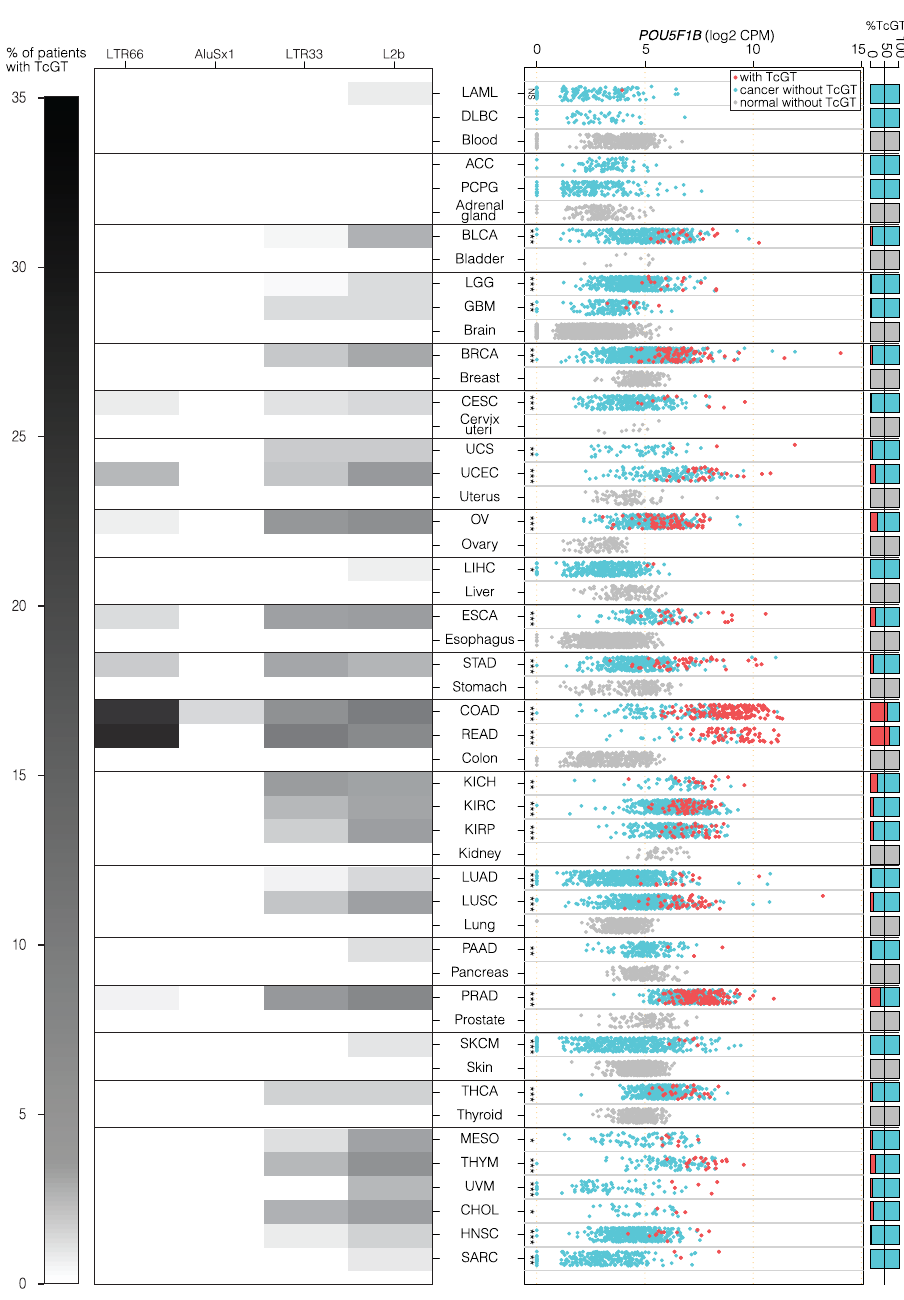
CESC cervical squamous cell carcinoma; CHOL cholangiocarcinoma; COAD colon adenocarcinoma; DLBC diffuse large B-cell lymphoma; ESCA esophageal carci- noma; GBM glioblastoma multiforme; HNSC head, and neck squamous cell carci- noma; KICH kidney chromophobe; KIRC kidney renal clear cell carcinoma; KIRP kidneyrenalpapillarycellcarcinoma;LAMLacutemyeloidleukemia;LGGlowgrade glioma; LIHC liver hepatocellular carcinoma; LUAD lung adenocarcinoma; LUSC lung squamous cell carcinoma; MESO mesothelioma; OV ovarian cancer; PAAD pancreaticadenocarcinoma;PCPGpheochromocytoma,andparaganglioma;PRAD prostate adenocarcinoma; READ rectal adenocarcinoma; SARC sarcoma; SKCM skin cutaneous melanoma; STAD stomach adenocarcinoma; THCA thyroid carci- noma;THYMthymoma;UCEC uterine corpusendometrialcarcinoma;UCSuterine carcinosarcoma; UVM uveal melanoma.